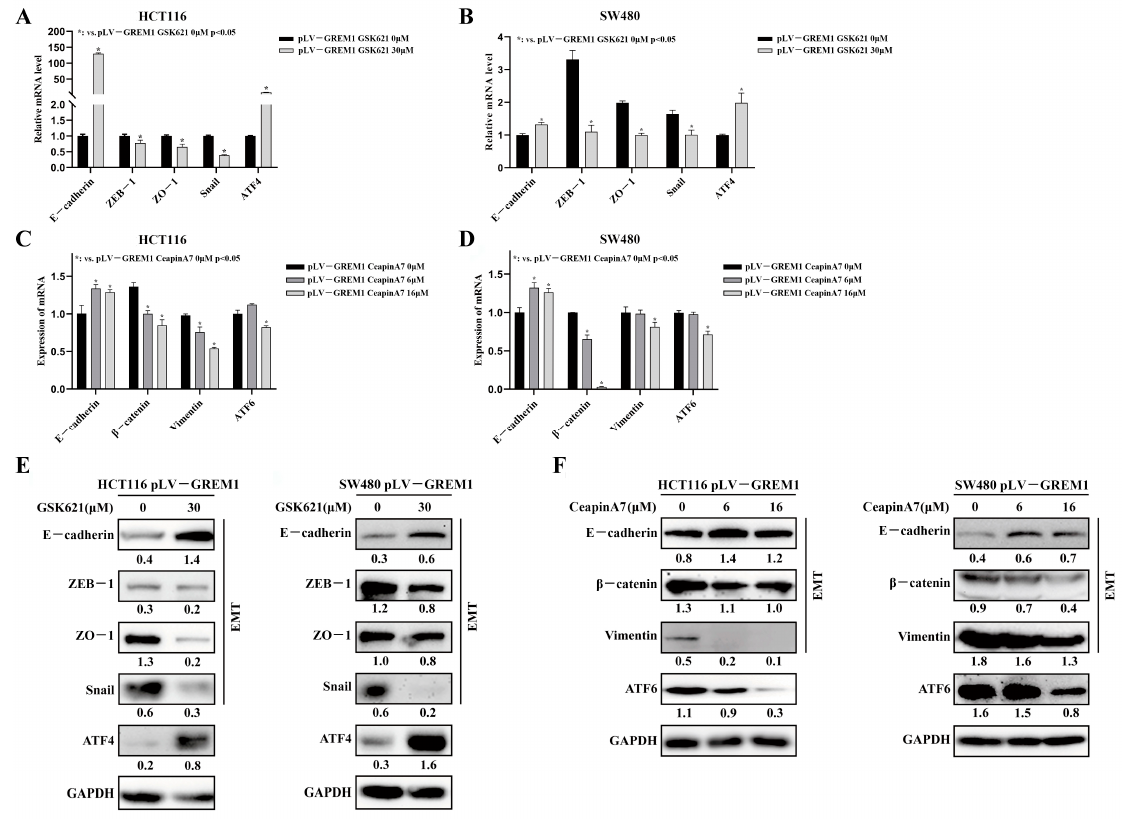
Figure 5. CeapinA7 and GSK621 reverse EMT in GREM1 -overexpressing CRC cell lines. HCT116 pLV-GREM1 and SW480 pLV-GREM1 cells were exposed to CeapinA7 (6 μ M,16 μ M) or GSK621 (30 μ M) for 24 h, respectively. After harvesting, the cells were analyzed for protein and mRNA expression. ( A – D ) qRT-PCR analysis revealed the expression of mRNA involved in EMT. ( E , F ) Western blotting analysis revealed the expression of proteins involved in the EMT.